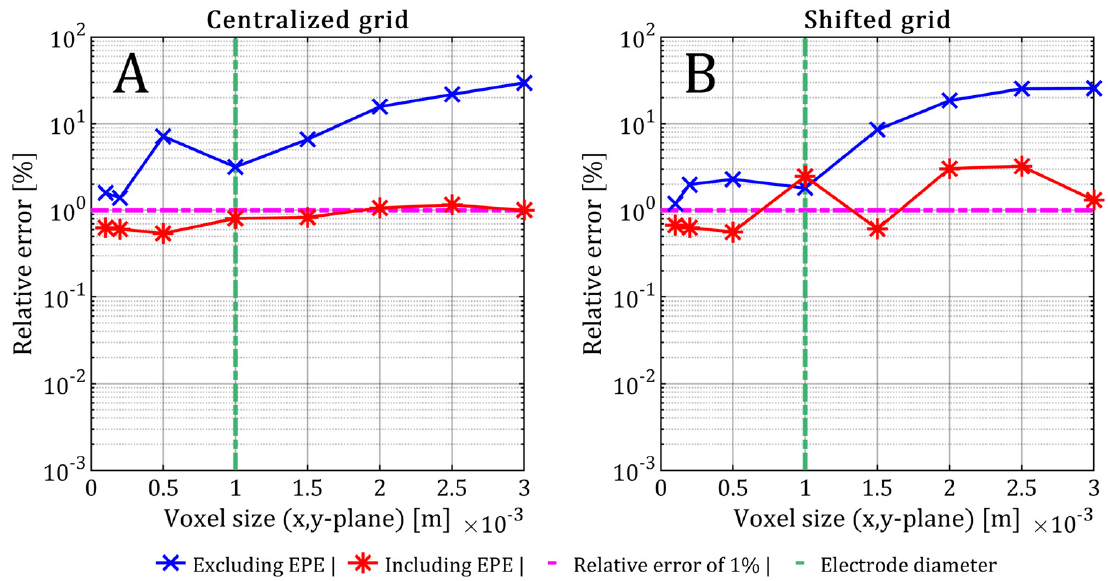
Figure 11. Relative error of the numerically calculated resistance values of the cylindrical electrode pair model with respect to the analytical resistance value as a function of voxel sizes for ( A ) centralized and ( B ) shifted grids.